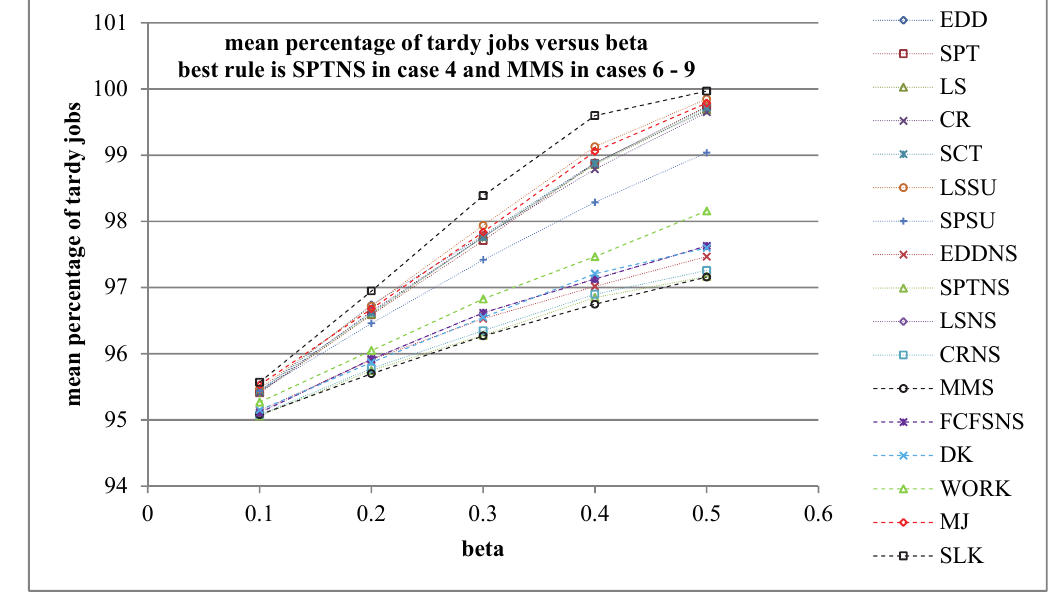
Fig. 8. Mean percentage of tardy jobs for simulation cases 4, 6, 7, 8, 9